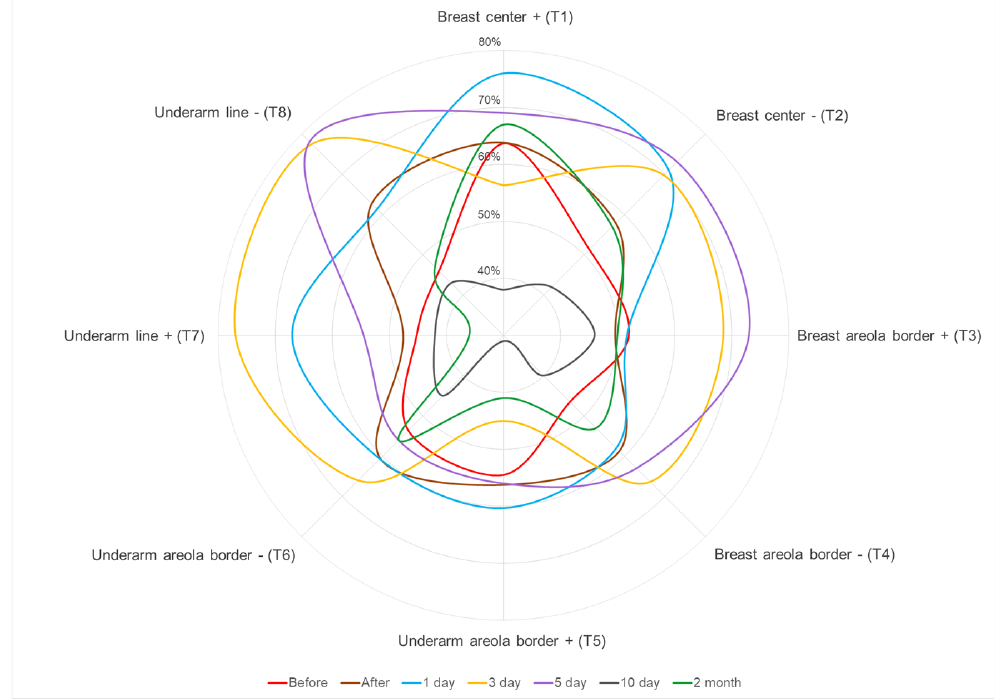
Figure 5. Polar plot of StO 2 changes for each test point of breast measure, the color of the curve determines the day of measurement. The values of the polar axis corresponded to the StO 2 value in percent. Axes at different angles correspond to measurement points. The days of the measurements are highlighted in